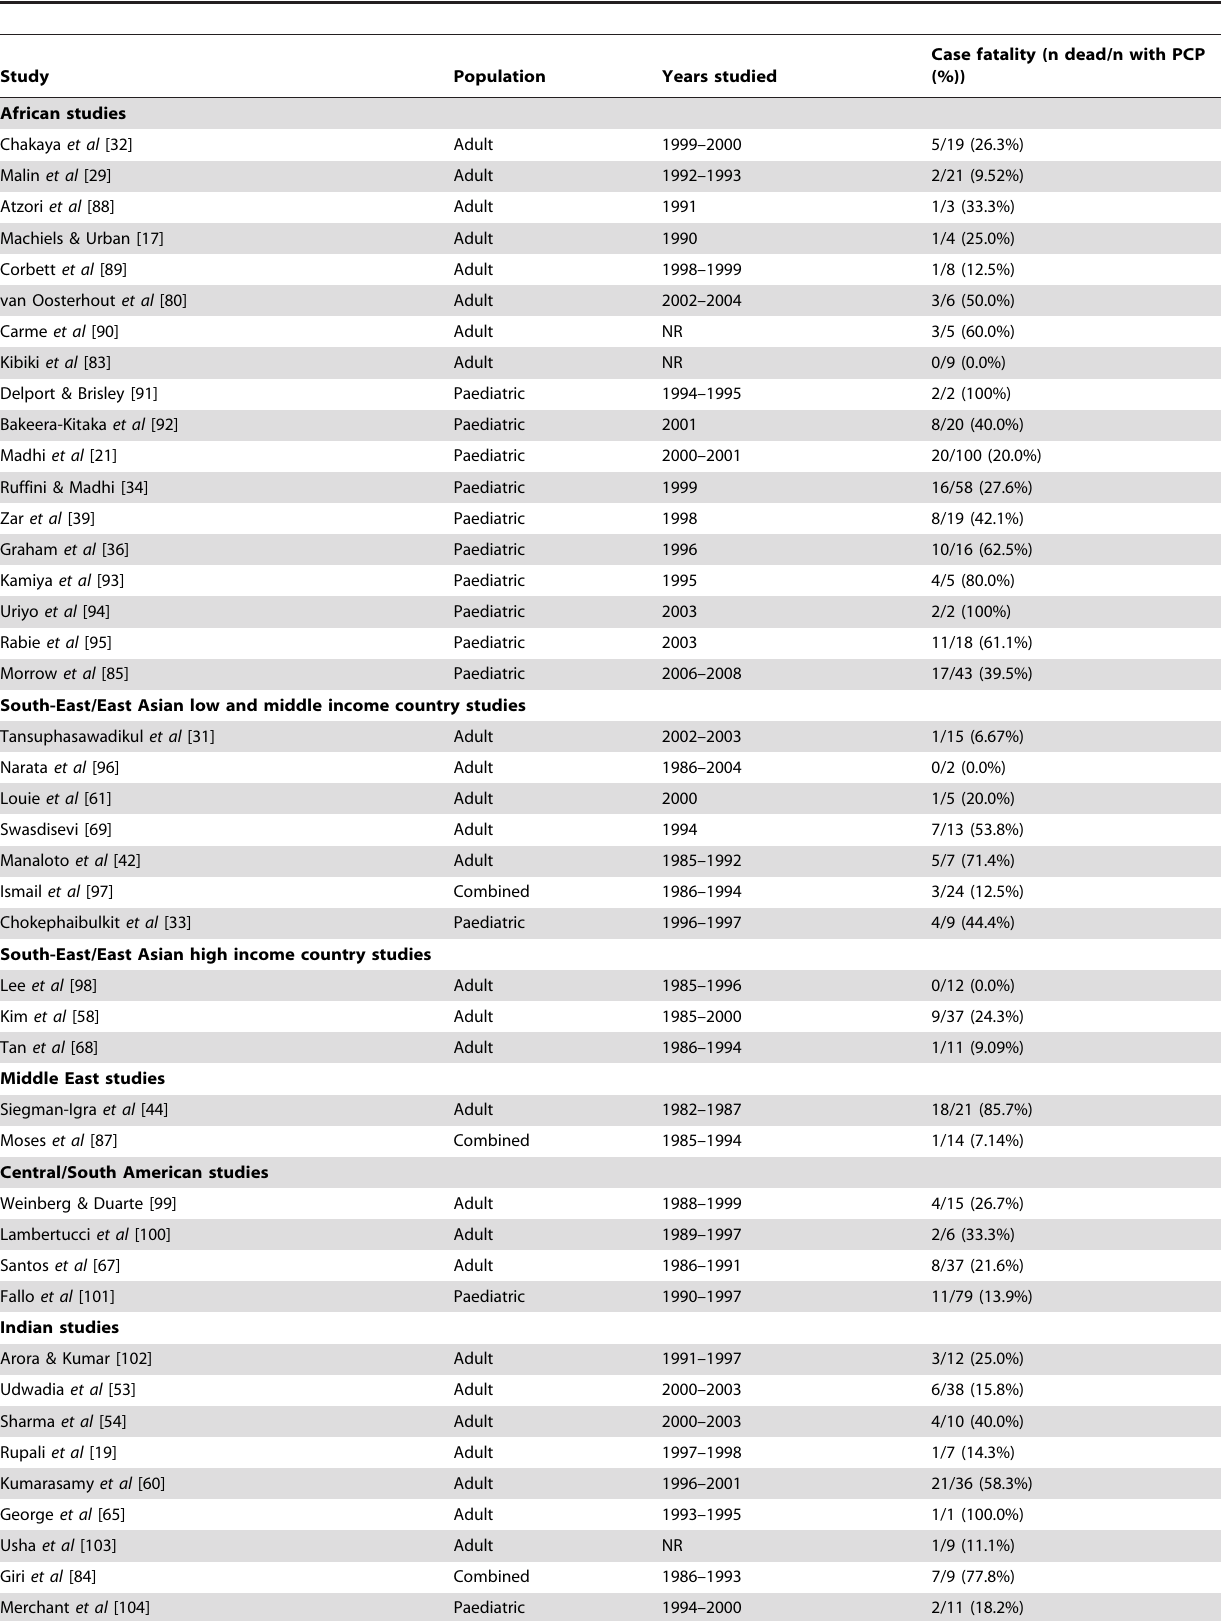
Table 7. Case fatality amongst people with a diagnosis of PCP in included